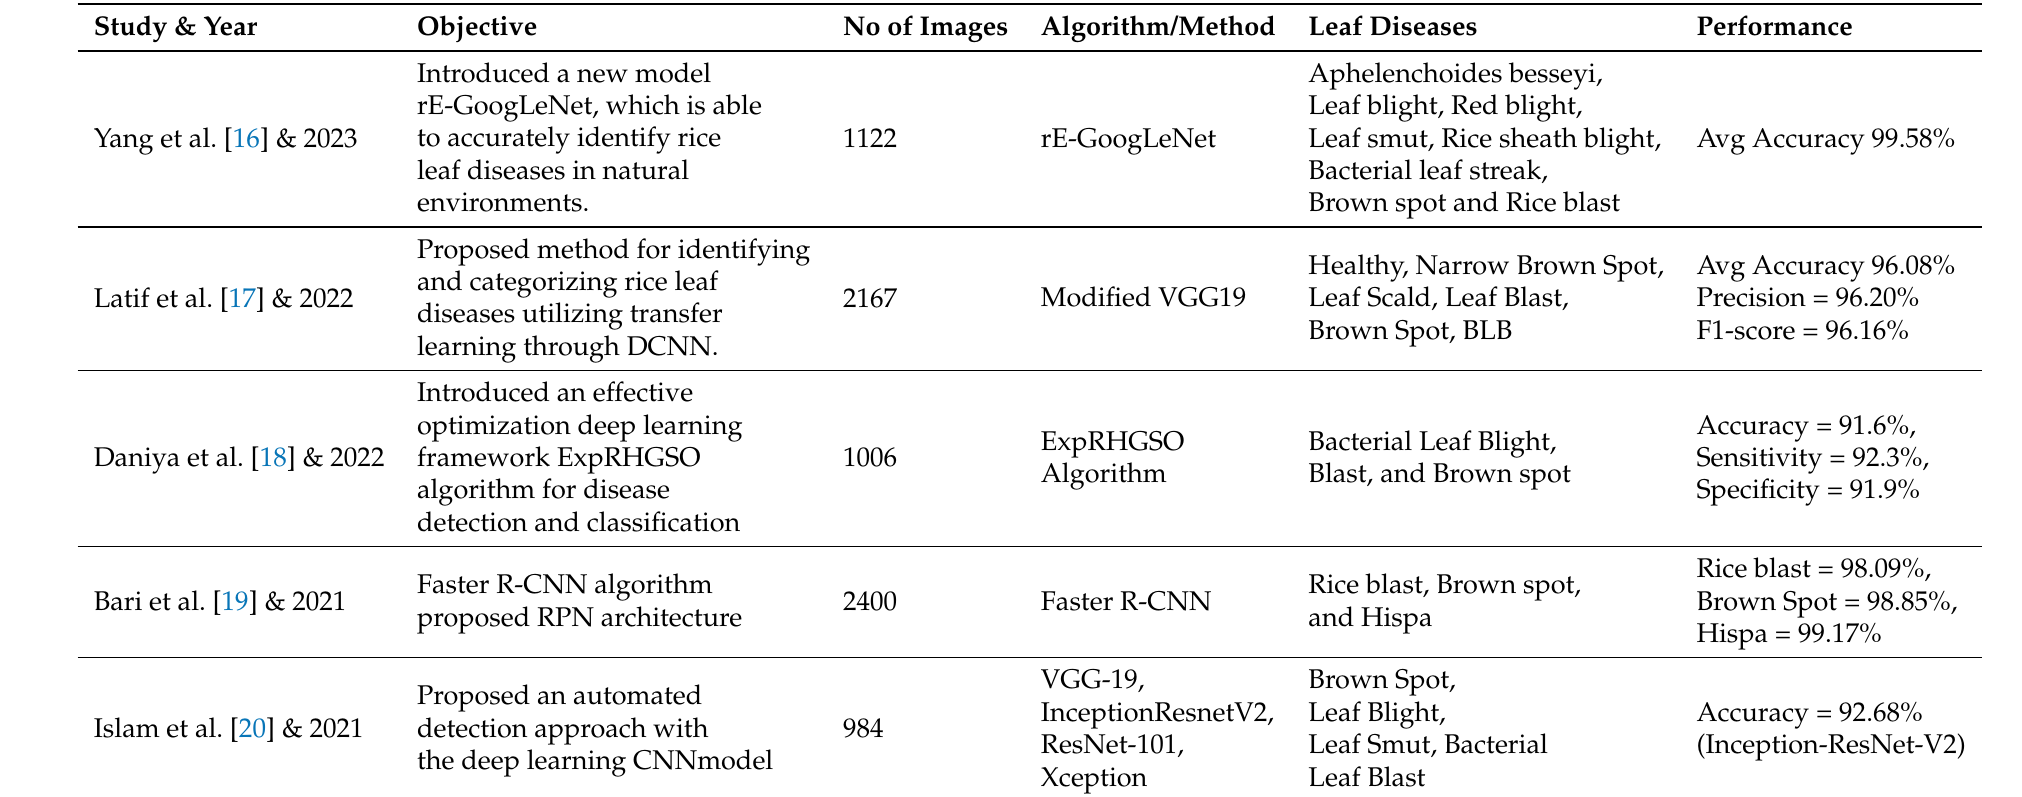
Table 2. Related Literature Survey to Classify and identify rice leaf